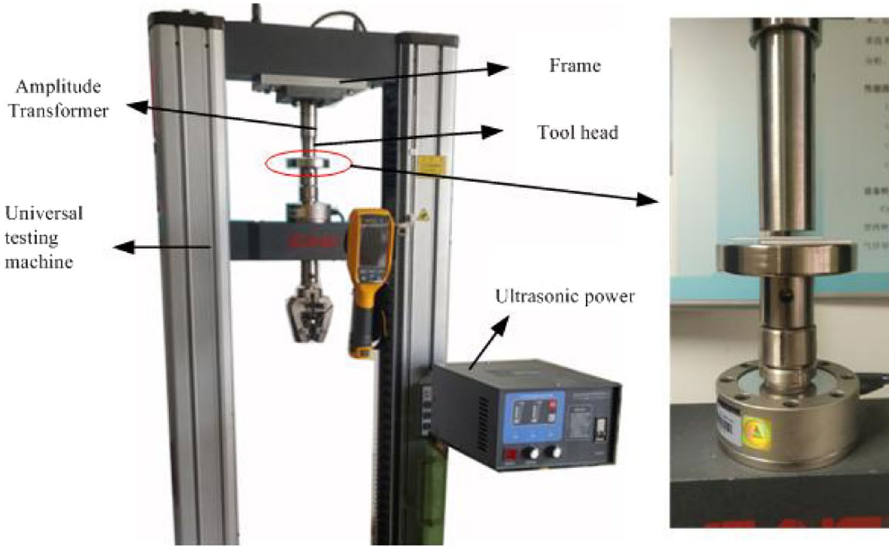
Figure 1. Ultrasonic-assisted riveting test system.